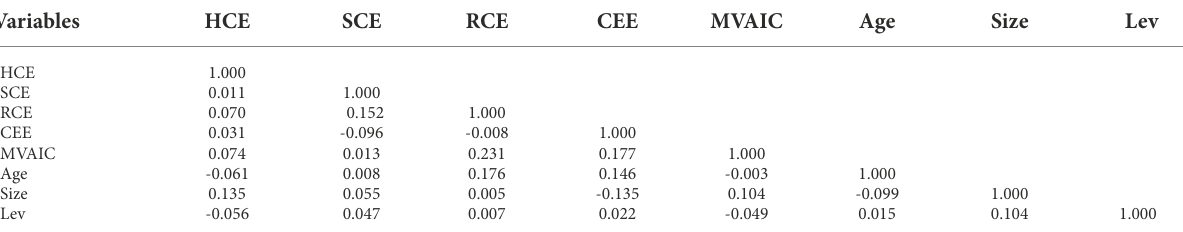
Table 5 Correlation analysis of Indian